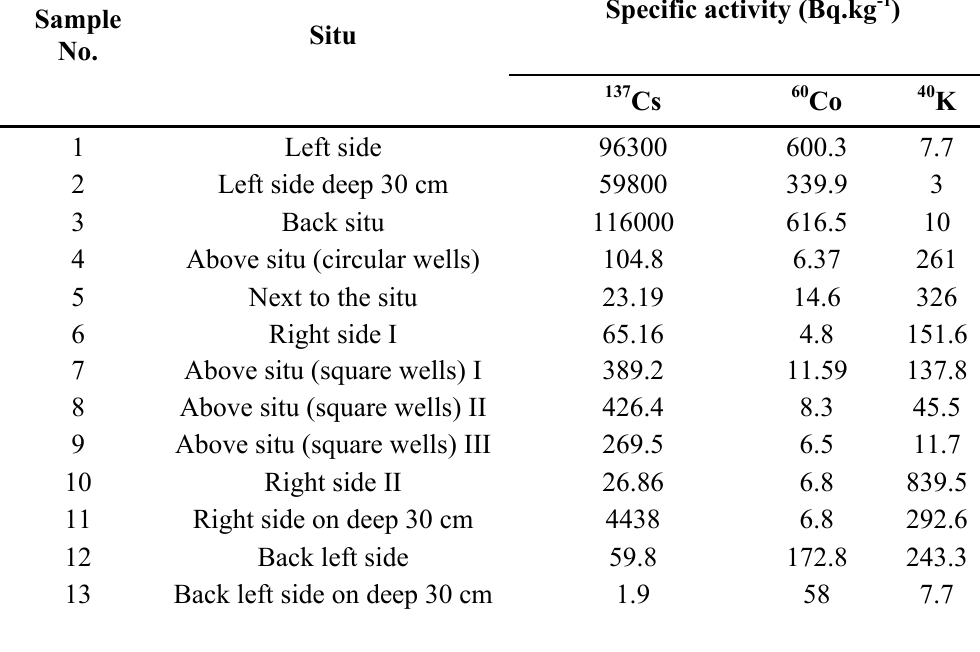
and above the RC